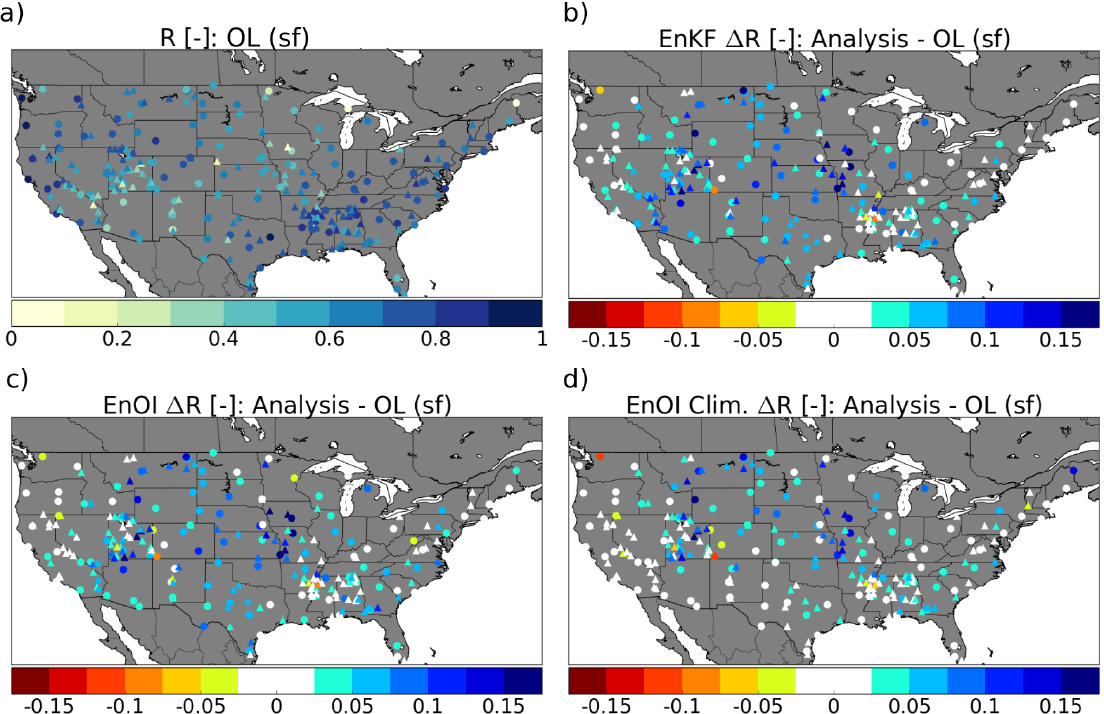
Figure 5. ( a ) Pearson R correlation coefficient between the ensemble open-loop (eOL) surface zone soil moisture and the SCAN (triangles) and USCRN (circles) stations. Yellow/blue indicate low/high correlation; ( b ) ∆ R (EnKF correlation minus eOL correlation), blue/red colours indicate positive/negative impact (226 of 259 stations improved); ( c ) ∆ R EnOI (190 of 259 stations improved); ( d ) ∆ R EnOI-Clim (183 of 259 stations